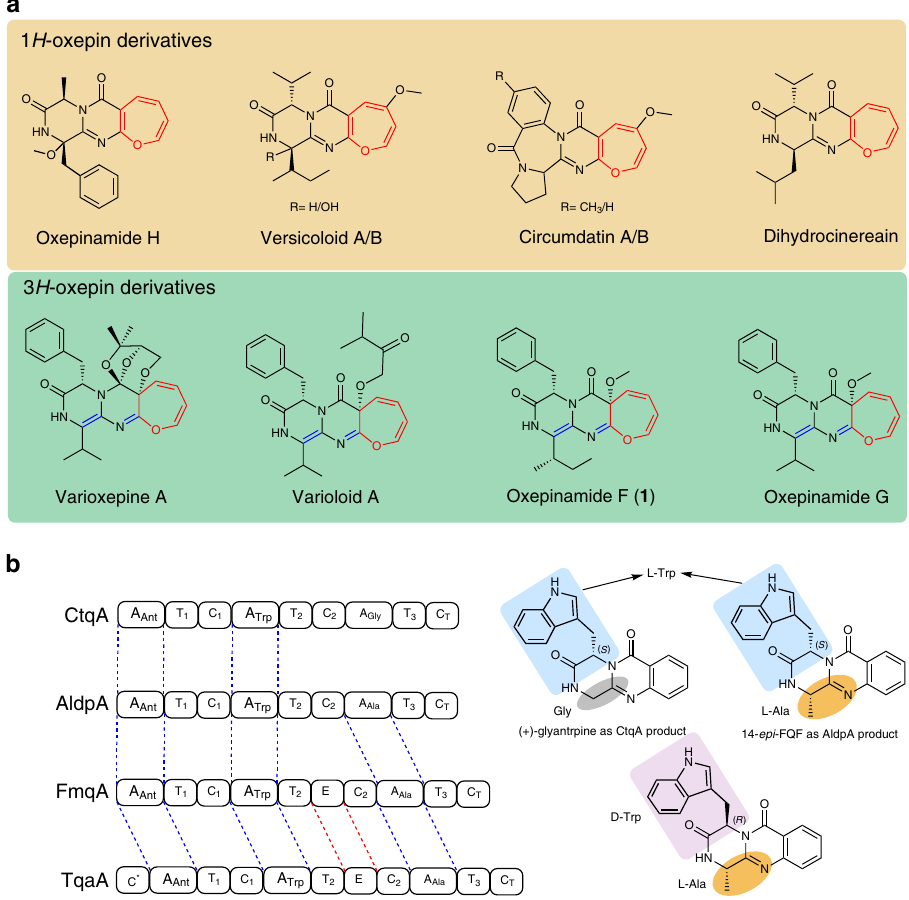
Fig. 1 Oxepinamides and backbone enzymes. a Examples of fungal oxepinamides including 1 H -oxepins and 3 H -oxepins. b Known NRPSs for quinazolinone